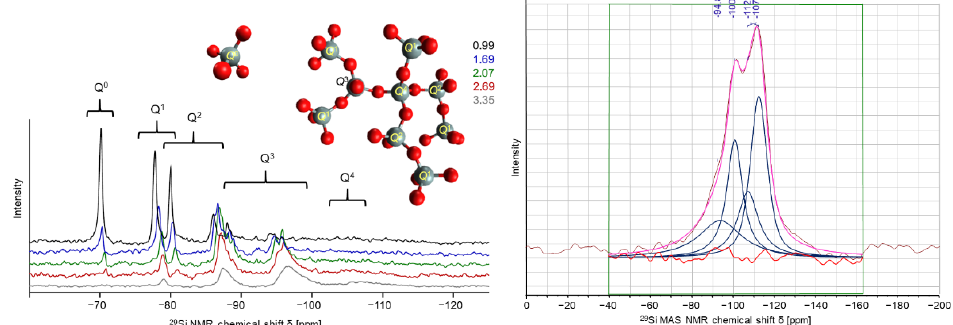
Figure 8. left : Q n distribution in liquid 29 Si NMR with RIDE pulse sequence of pure sodium water glasses, adapted from [21] and right : deconvoluted 29 Si MAS NMR spectra of a potassium water glass with aluminum tetrametaphosphate [22].